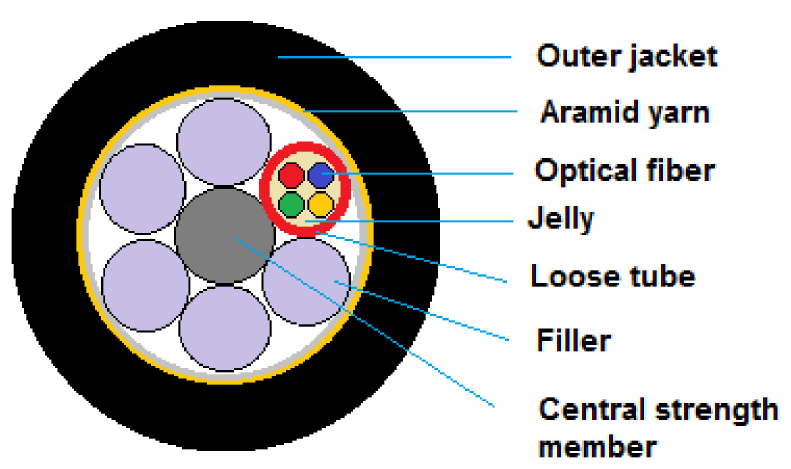
Figure 1. Schematic cross-section of the optic cable tested with four fibres. The number of fibres in the tests were four (as in the drawing) and/or 12 in each tube.